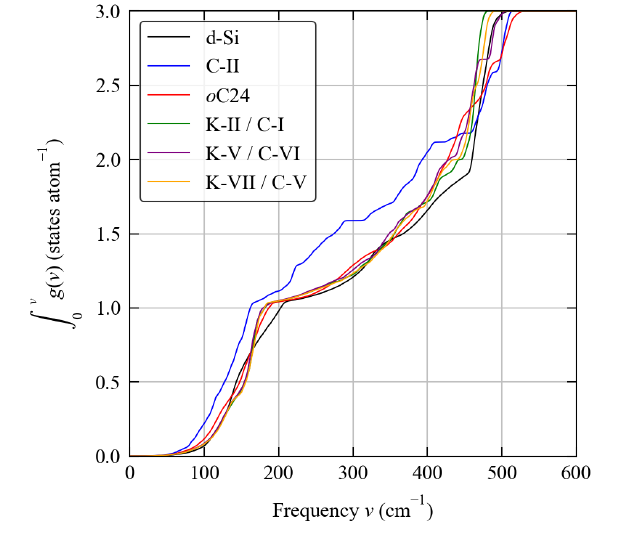
Figure 3. Cumulative integral of the phonon density of states curves g ( ν ) in Figure 2 as a function of frequency showing the distributions of modes over